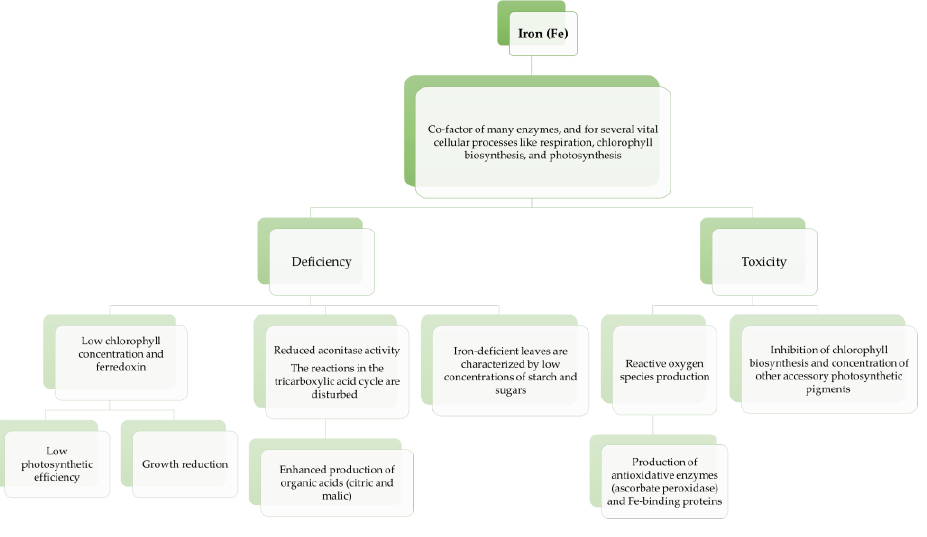
Figure 1. Main effects of iron (Fe) in plants.